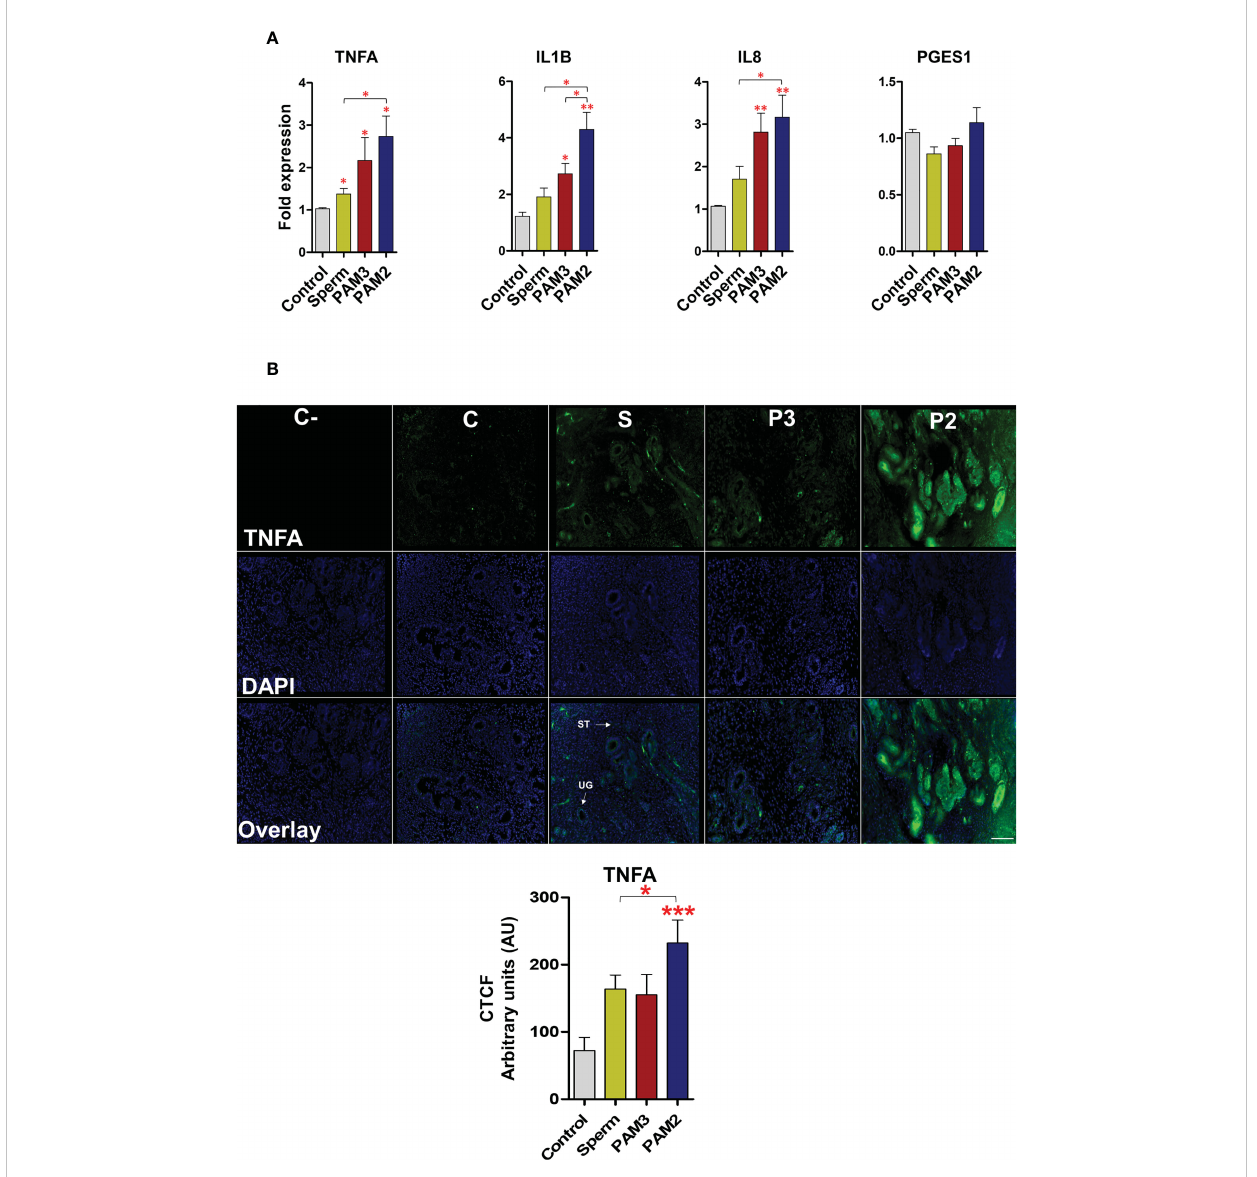
FIGURE 5 Sperm and PAM3 induce a weaker in fl ammation in bovine endometrial explants, compared with PAM2. (A) Relative mRNA expression of pro- in fl ammatory cytokines and PGES1 after stimulation with 5 million/mL sperm, 100 ng/mL PAM3 and PAM2 for 3h. This experiment was repeated seven times using epithelial cells from seven different uteri. (B) Immuno fl uorescence staining for TNFA in endometrial explants (C : Negative control, C: Control, S: Sperm, P3: PAM3 and P2: PAM2). This experiment was repeated three times using explants from three different uteri. Asterisks show a signi fi cance of difference (*P < 0.05, **P < 0.01 or ***P < 0.001 , Mann – Whitney test) between the means of each two independent groups. Bar = 100